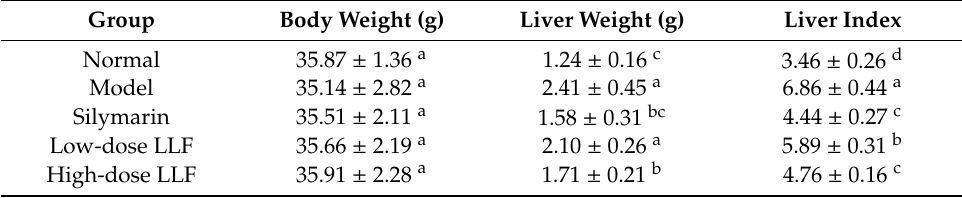
Table 6. The body weight, liver weight, and liver index of mice ( n =